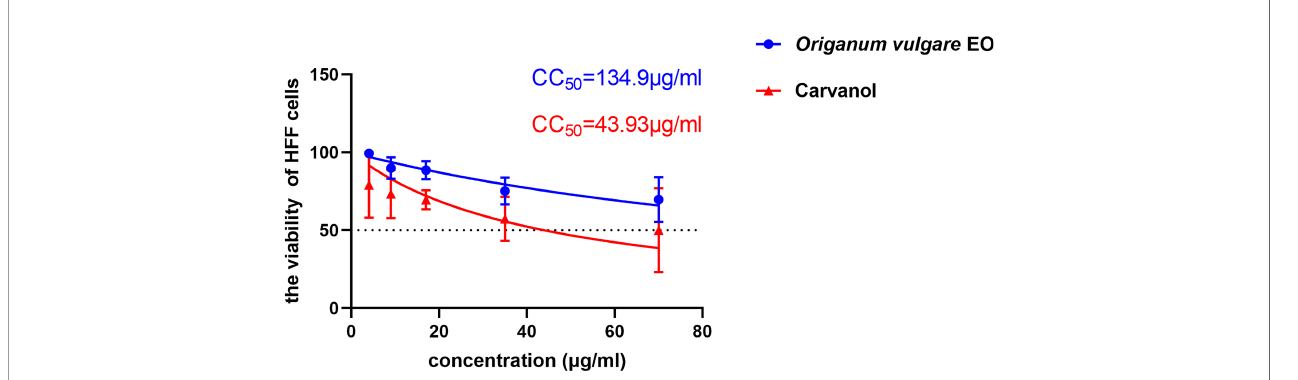
FIGURE 1 | The 50% cytotoxic concentrations (CC 50 ) of Ov EO and Ca. Cytotoxicity of Ov EO and Ca on HFF cells. Different concentrations of Ov EO and Ca treat HFF cells for 24 h and then cytotoxicity was evaluated using MTT Assay. All data are presented as with error bars and the experiments were performed